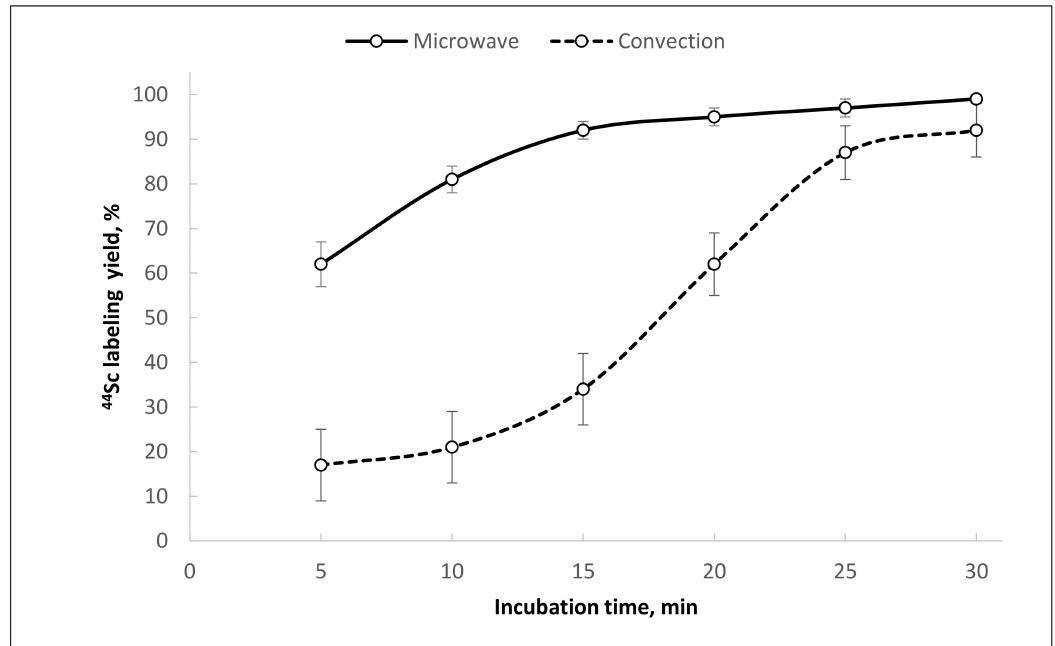
Figure 10. Kinetics of [ 44 Sc]Sc-PSMA-617 formation using 44 Sc after reformulation with Presep ® PolyChelate into 0.1 M HCl under different heating modes (95 ◦ C, V = 1.0 mL, pH = 4.5, 50 nmol PSMA-617).